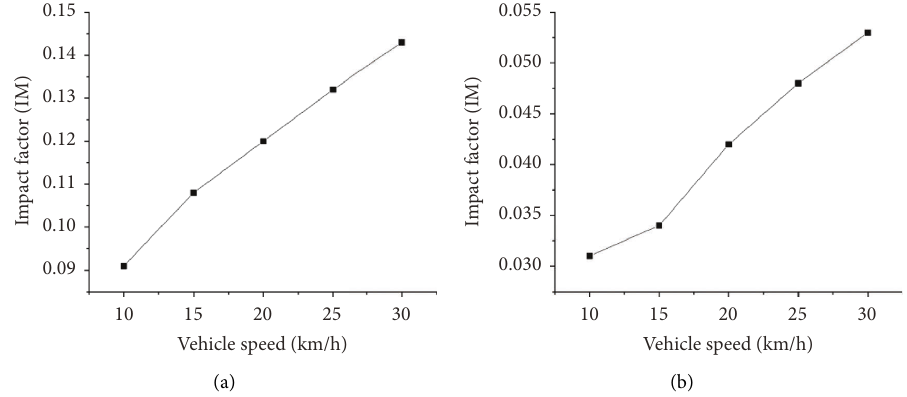
Figure 19: The impact factor in different locations. (a) Support. (b) A quarter of the